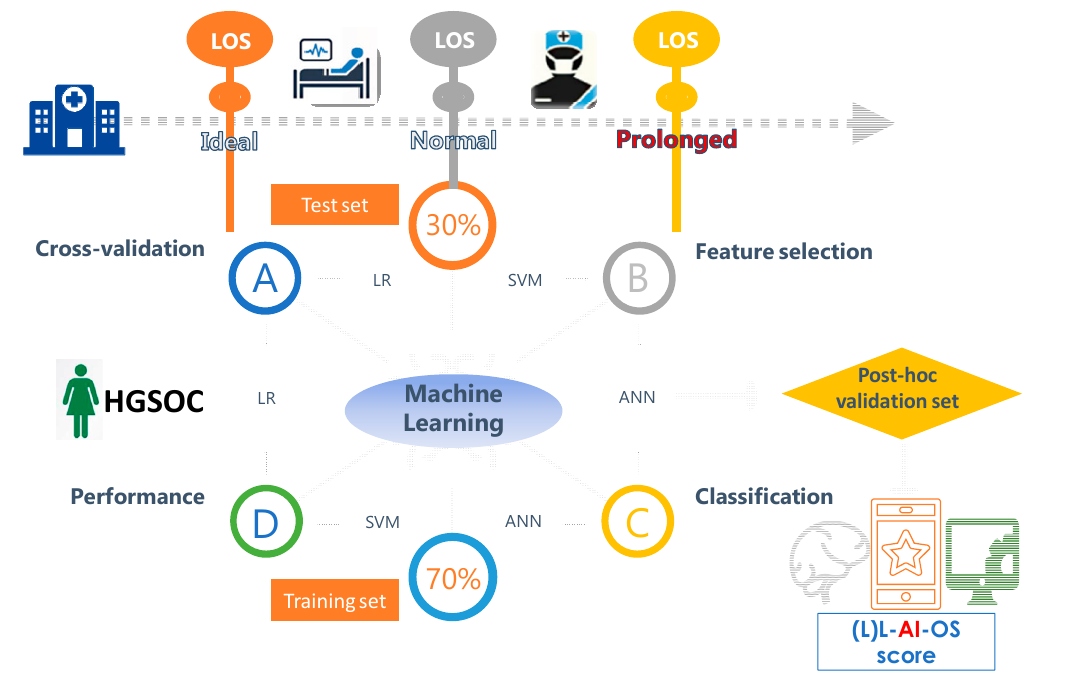
Figure 1. Workflow and organization for model selection, internal and post-hoc validation of the length of stay (LOS) prediction in advanced stage high grade serous ovarian cancer patients (HGSOC) following their cytoreductive surgery using Machine Learning. Both classification and numerical LOS predictions were interrogated. Table 2. Cohort descriptive